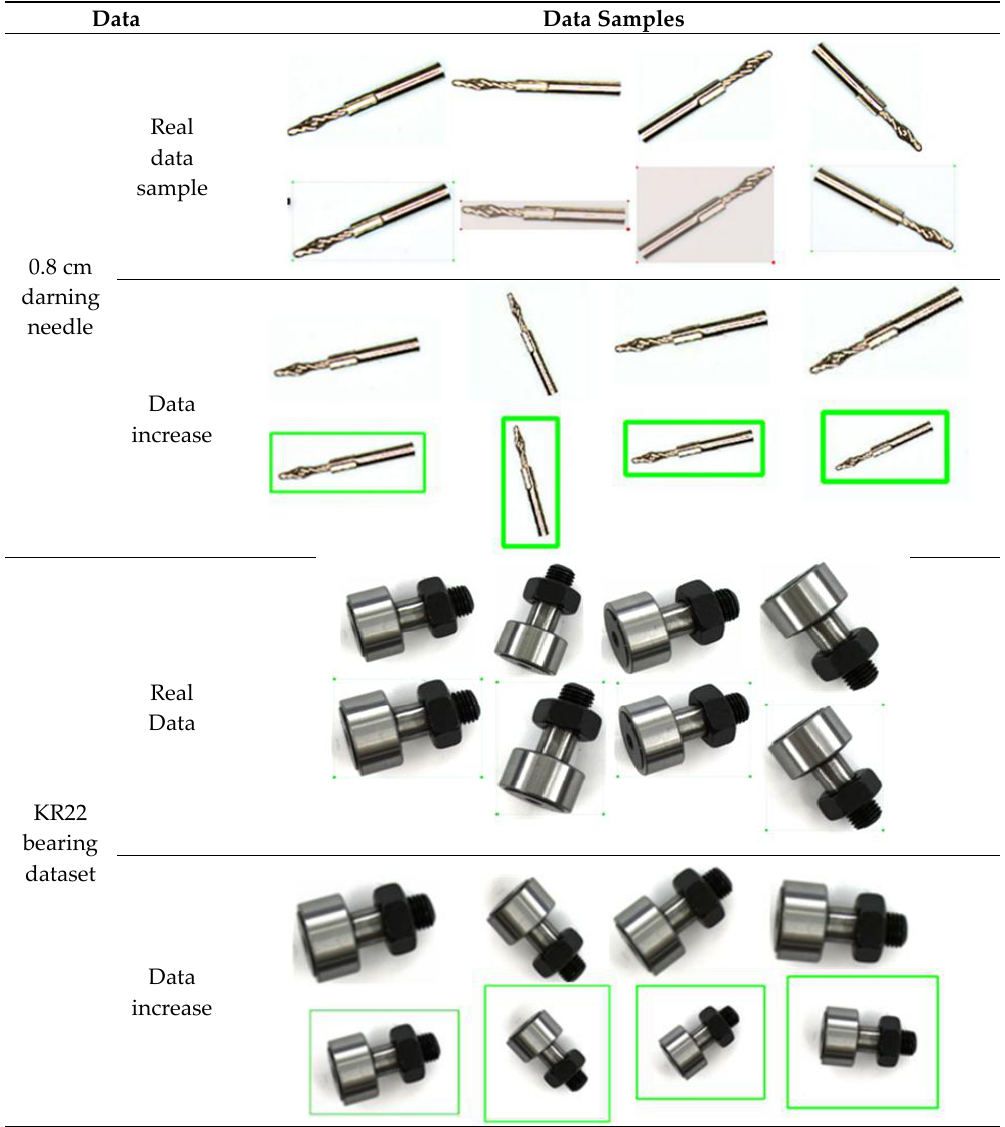
Figure 8. Comparison of experimental results between increased and real data in automatic and manual annotation.